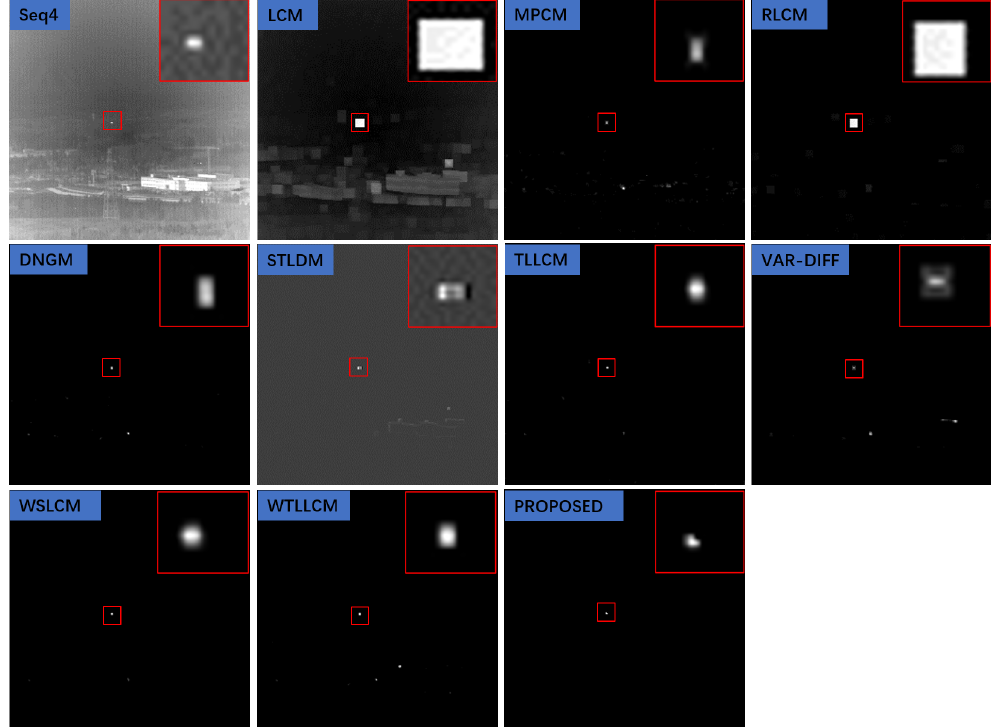
Figure A1. Detection results of one frame in data4. The first sub-image is the original image, and the rest are the detection results of each algorithm.